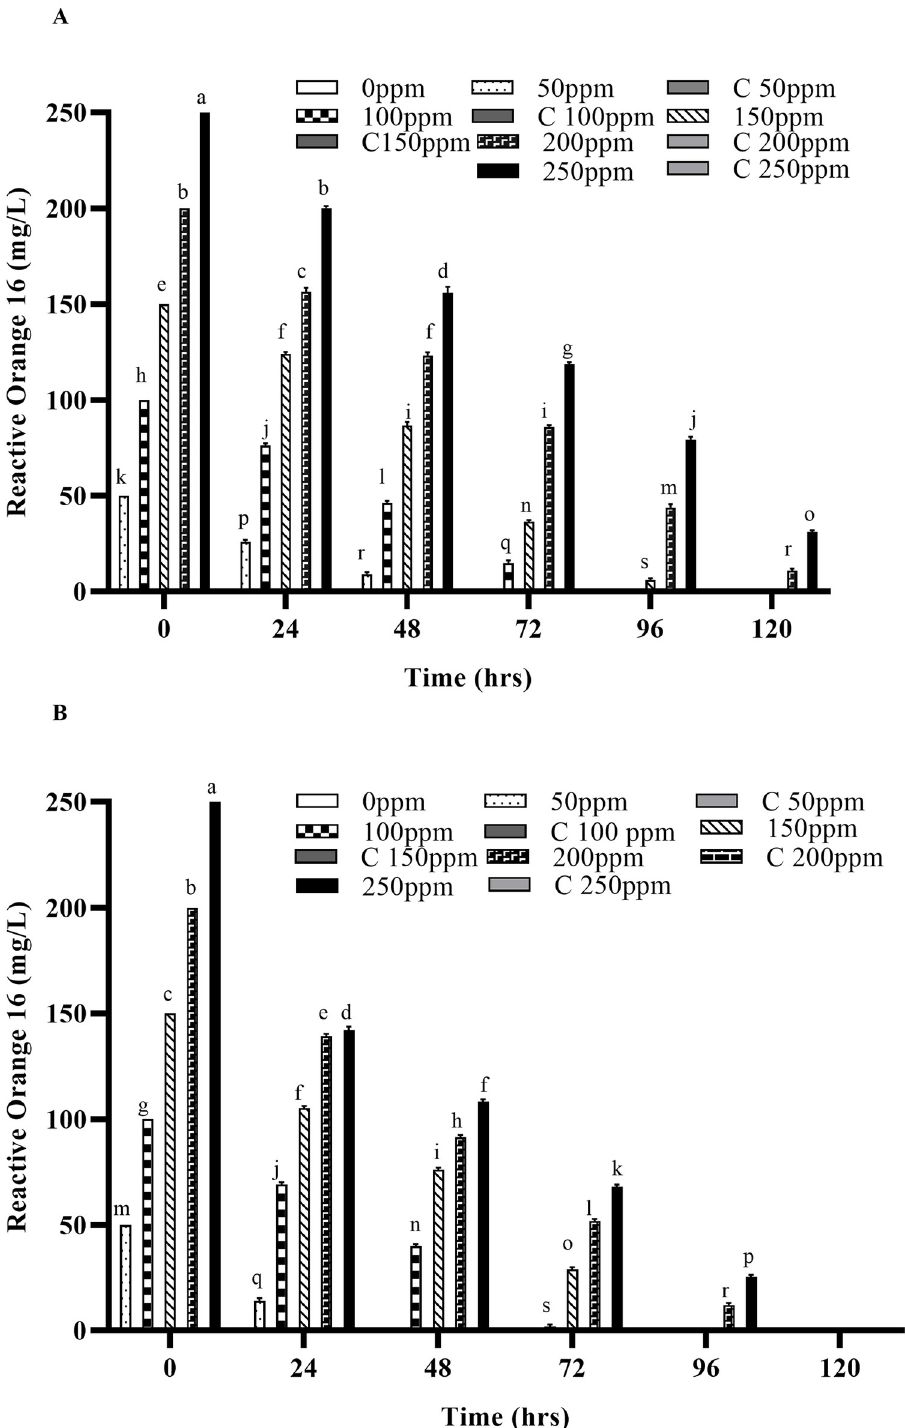
Fig 4. Concentrations of Reactive orange 16 degraded after treatment with free and immobilized cells of the bacterial strain (A) Degraded by free cells at 37 ˚C (B) Degraded by immobilized cells at 37 ˚C. Different alphabets show the significant differences (p < 0.05) between different